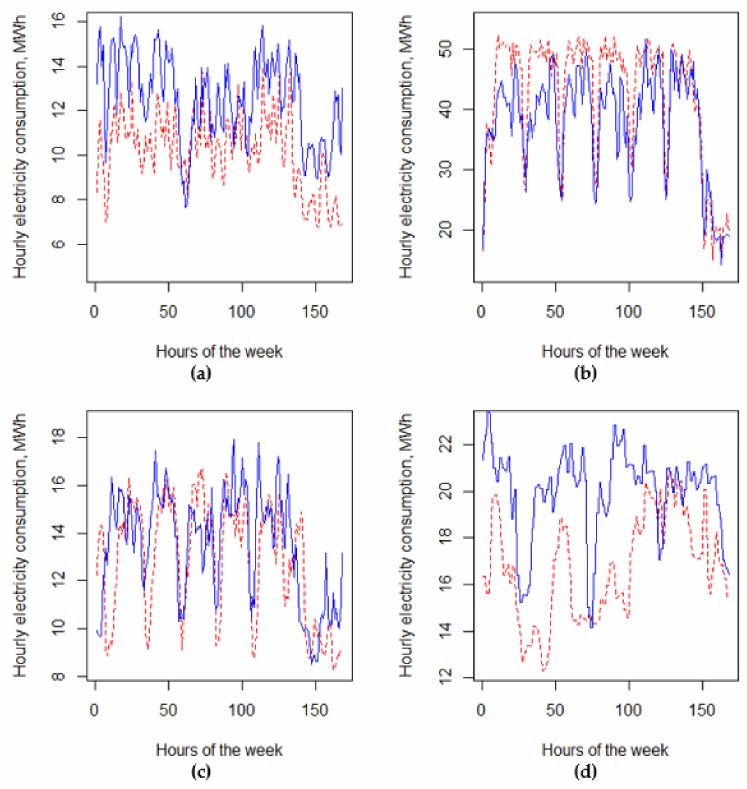
Figure 7. The course of electricity consumption in the selected week of February and August for the analyzed case of the research object: ( a ) M1, ( b ) M2, ( c ) M3 and ( d ) M4. (blue solid line—February; red dashed line—August). Source: own